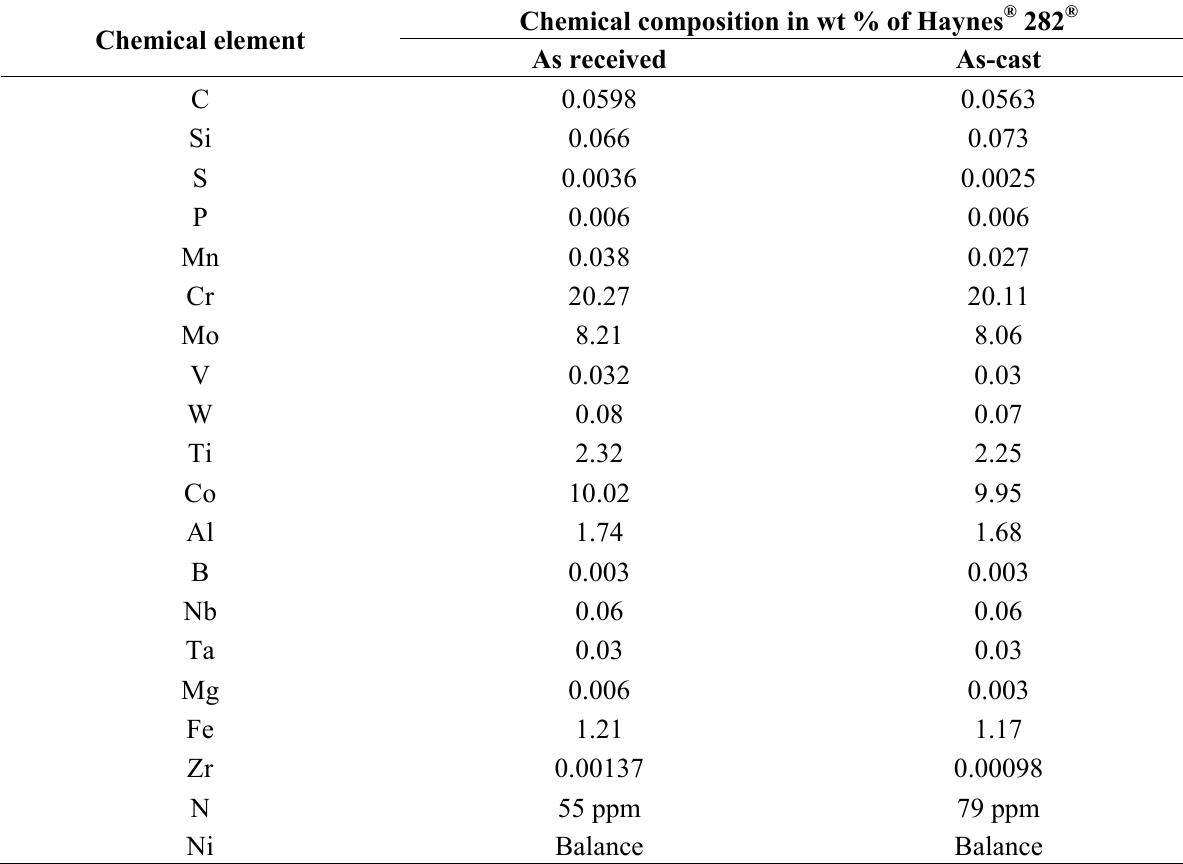
Table 1. Chemical composition in wt % of Haynes ® 282 ® (as received and as-cast state). Chemical